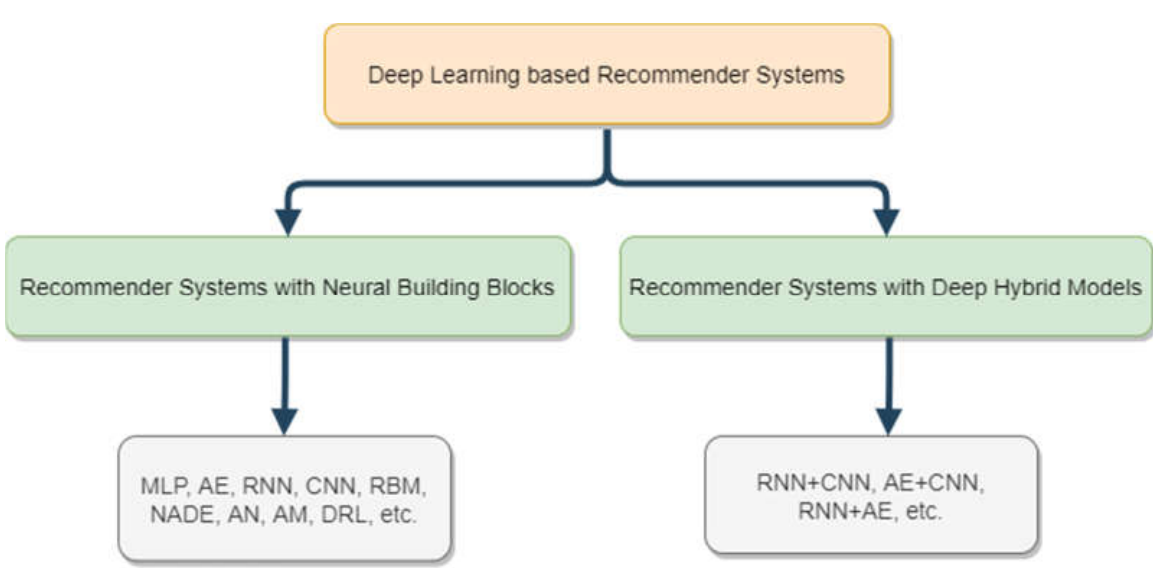
Figure 2. Categories of deep neural network-based recommendation models [25]. Multilayer Perceptron (MLP); Auto Encoder (AE); Convolutional Neural Network (CNN); Recurrent Neural Network (RNN); Restricted Boltzmann Machine (RBM); Neural Autoregressive Distribution Estimation (NADE); Adversarial Networks (AN); Attentional Models (AM); Deep Reinforcement Learning (DRL).